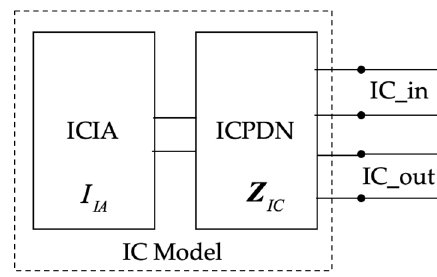
( a ) the measured conducted emission measured U at the port VOUT. VOUT